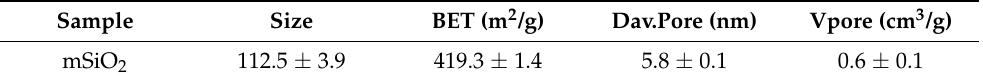
Table 1. Textural parameters of mSiO 2 . Data are presented as the mean ± standard deviation (SD; n = 3).